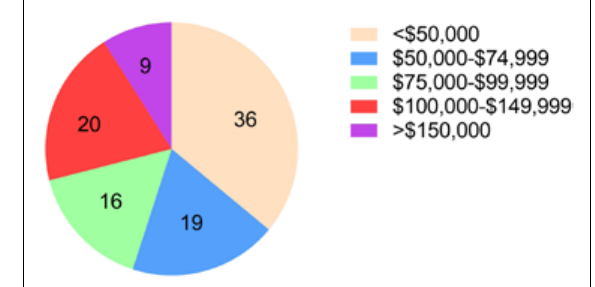
Figure 4. Income distribution of respondents (percent).